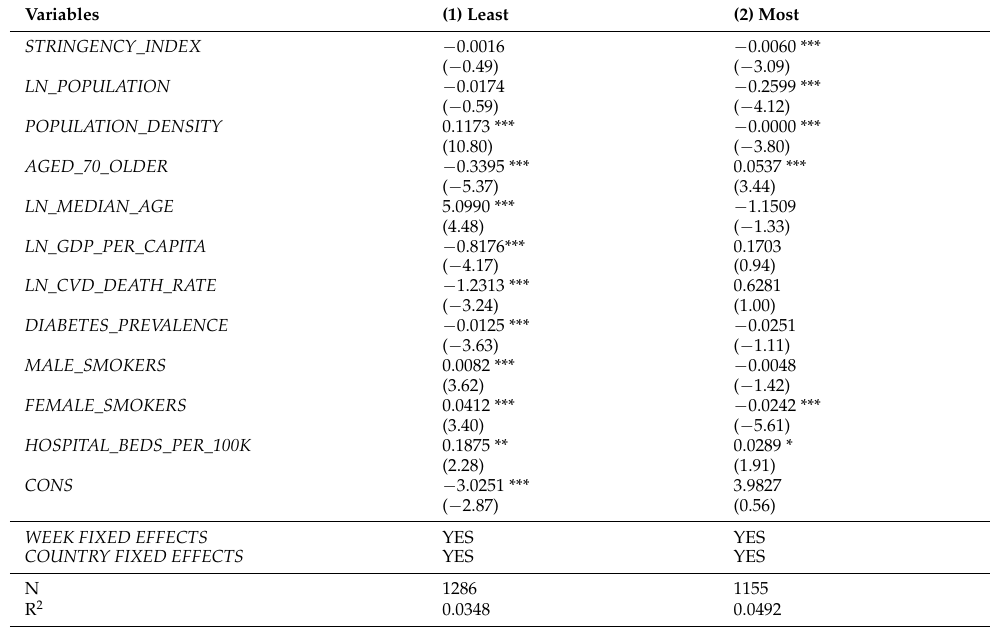
Table 5. Regression analysis of the effect of population density on the correlation between government responses and the COVID-19